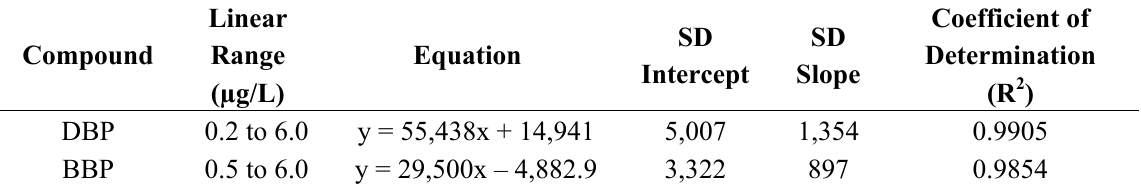
Table 2. Equations and determination coefficients for DBP and